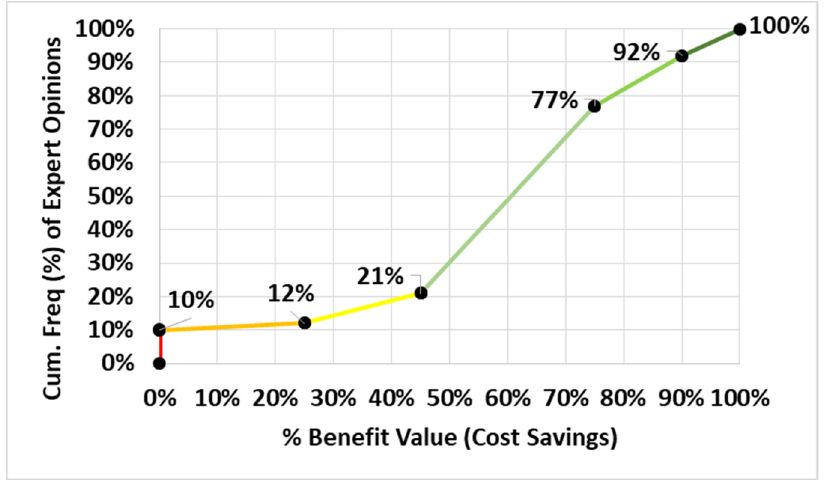
Figure 10. Operational costs and charge benefits: cumulative frequency (y-axis, annotated) of benefit values (x-axis), scaled per every 100 experts. The line is colour-coded in the same way as Figure 9 to enable easy comparison.